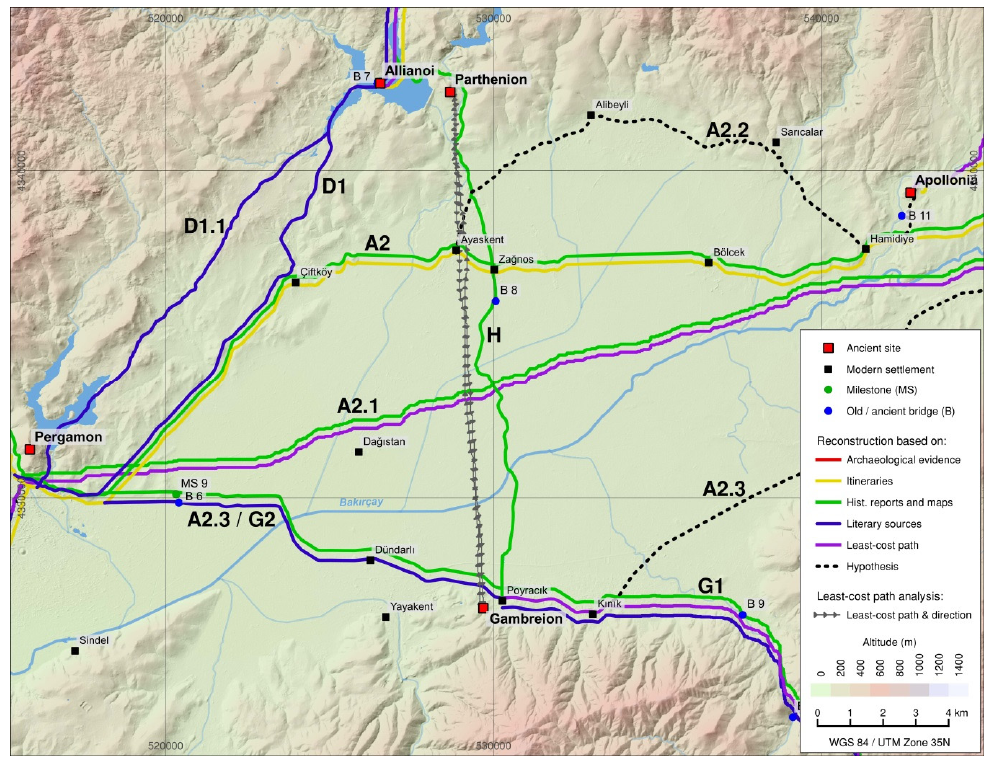
Figure 19. Calculated least-cost paths and reconstructed route between Parthenion and Gambreion.